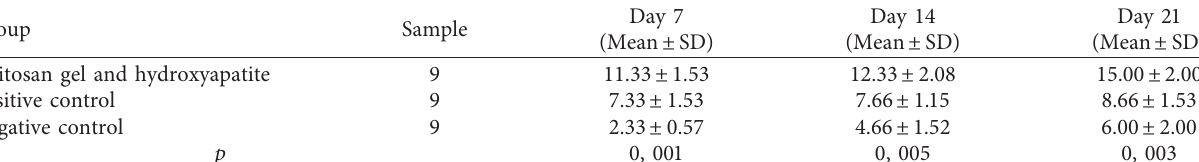
Table 1: Descriptive statistics showing results of BMP-2 expressions.